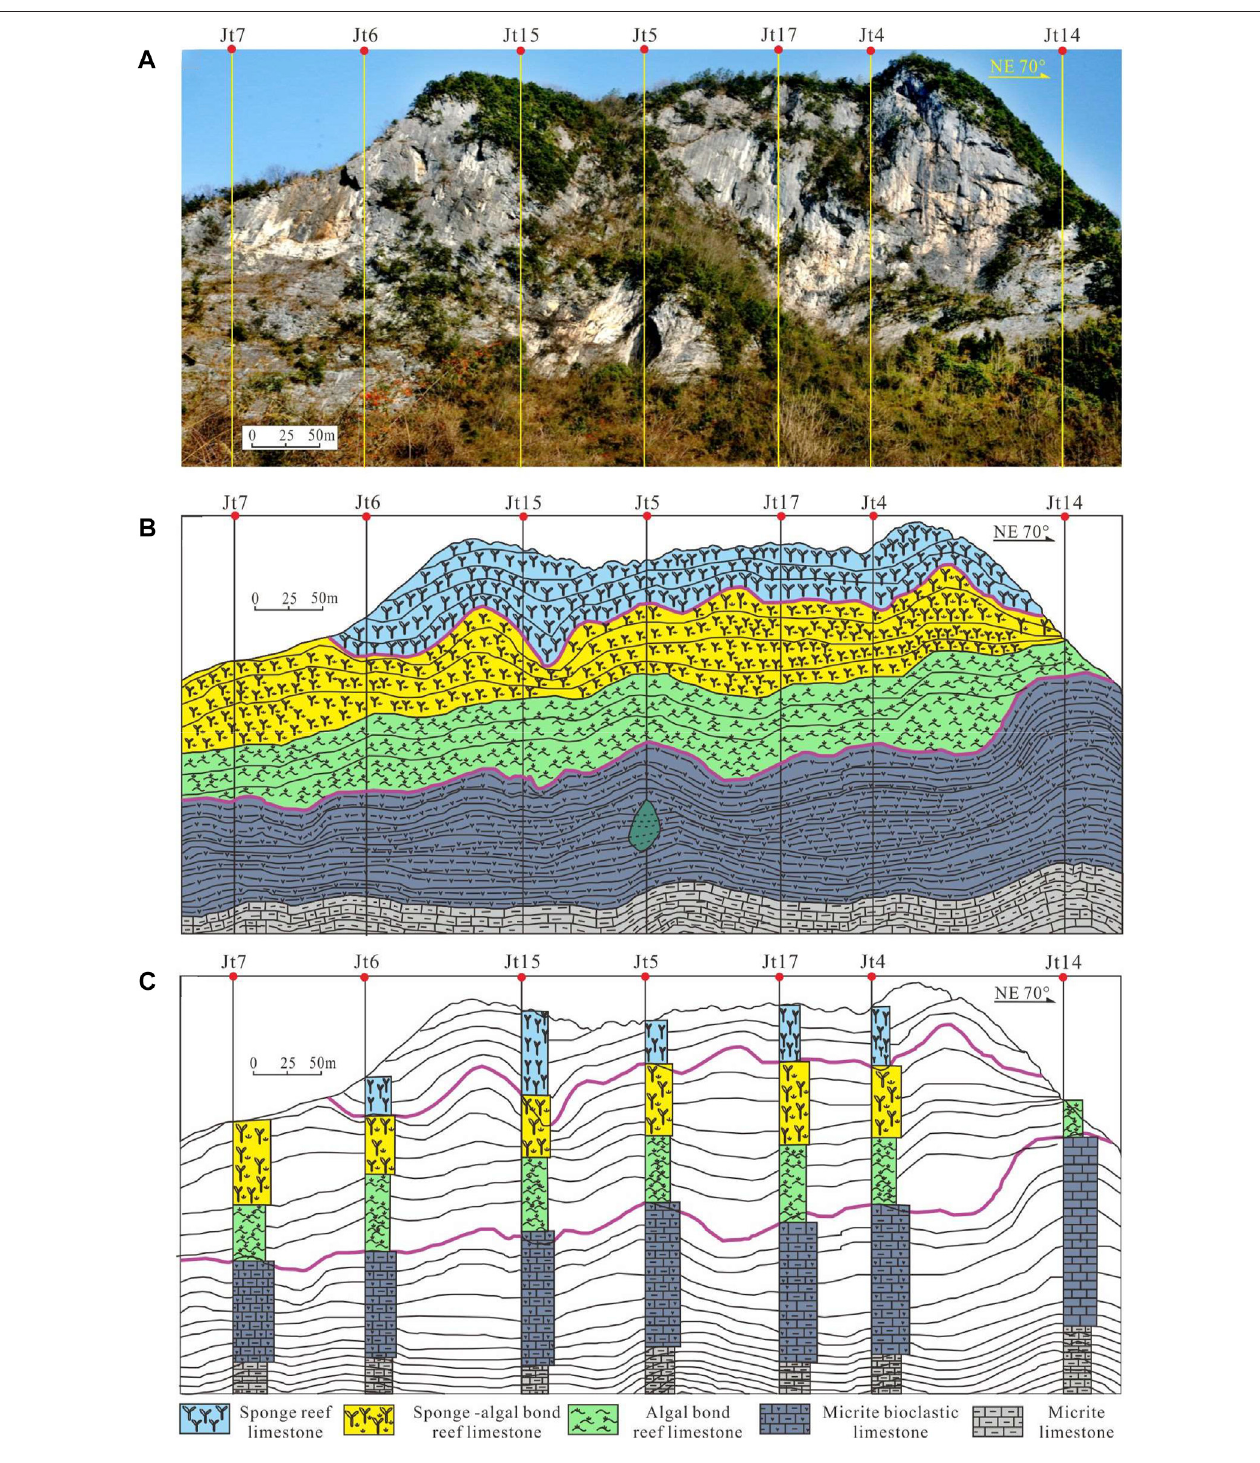
FIGURE 5 | Architecture geological model of Jiantianba AA ’ section, Lichuan. (A) Field outcrop picture; (B) outcrop pro fi le sketch; (C) architecture geological model.